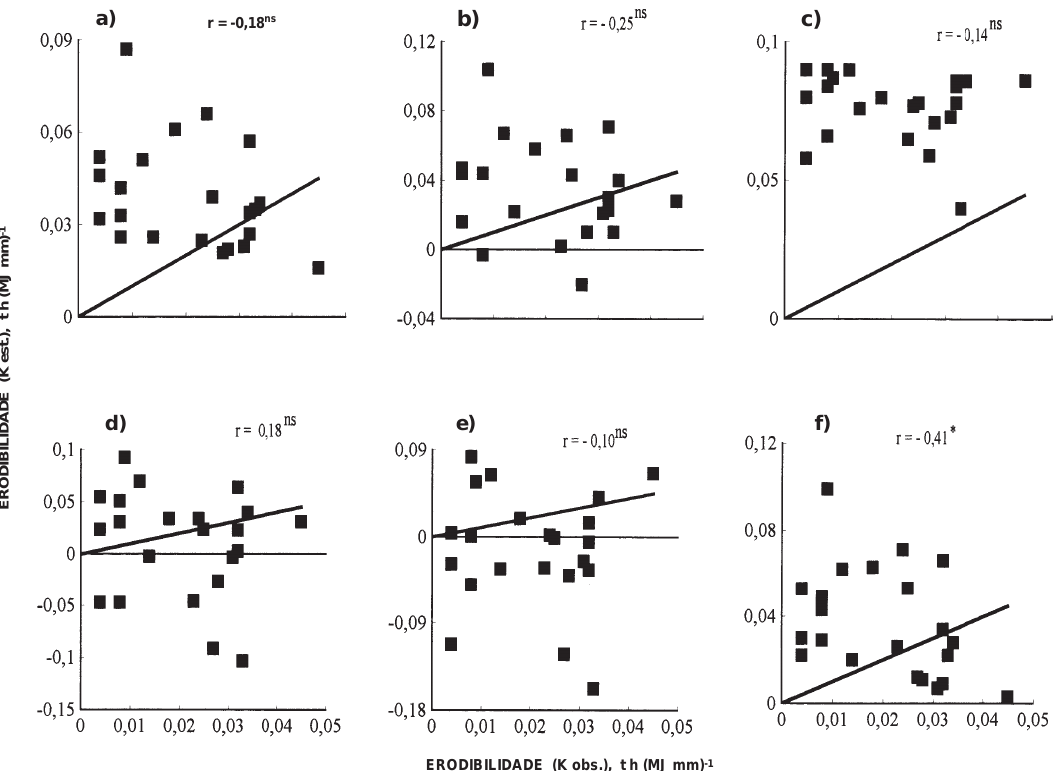
Figura 4. Relação entre o K estimado (K est.) pelos métodos 8 (a), 9 (b), 10 (c), 11 (d), 12 (e) e 13 (f) e o K observado (K obs.). O traço contínuo representa a linha 1:1 (* = significativo ao nível de 5%; ns = não